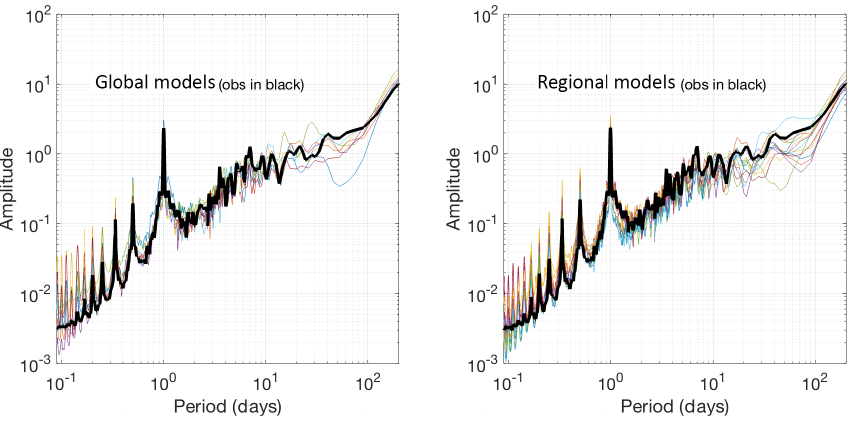
Figure 1. Power spectrum of observed ozone (thick line) obtained from the average 1-year time series across all measuring locations and of global models and regional